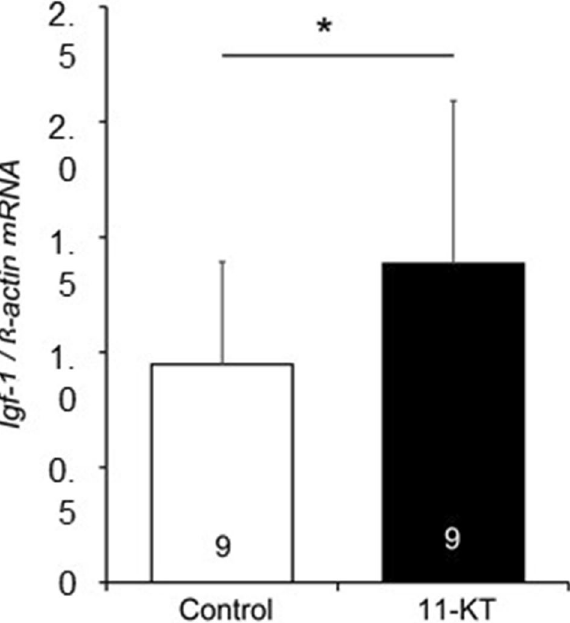
Figure 4. Changes in expressions of insulin-like growth factor 1 ( Igf-1) mRNA in control and 11-ketotestosterone-treated slices 1 h after the treatment. An asterisk indicates a significant difference at p < 0.05 (paired Student’s t -test). Numerals in bars indicate the numbers of animals used for preparing slices. Data are expressed as the mean ± standard error of the